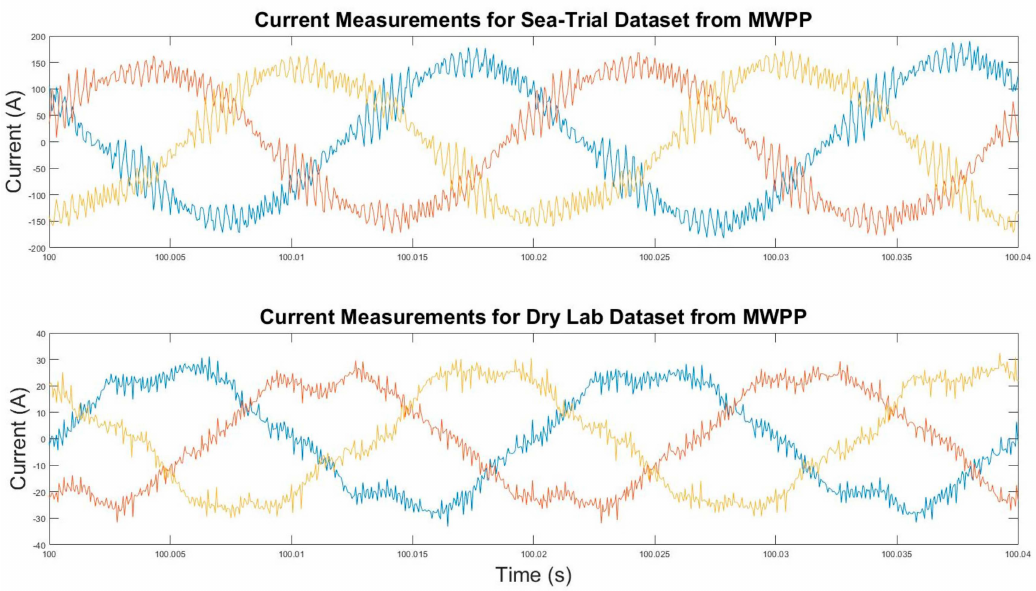
Figure 13. Current measurements from Mutriku Wave Power Plant (MWPP) sea-trails and Lir NOTF laboratory